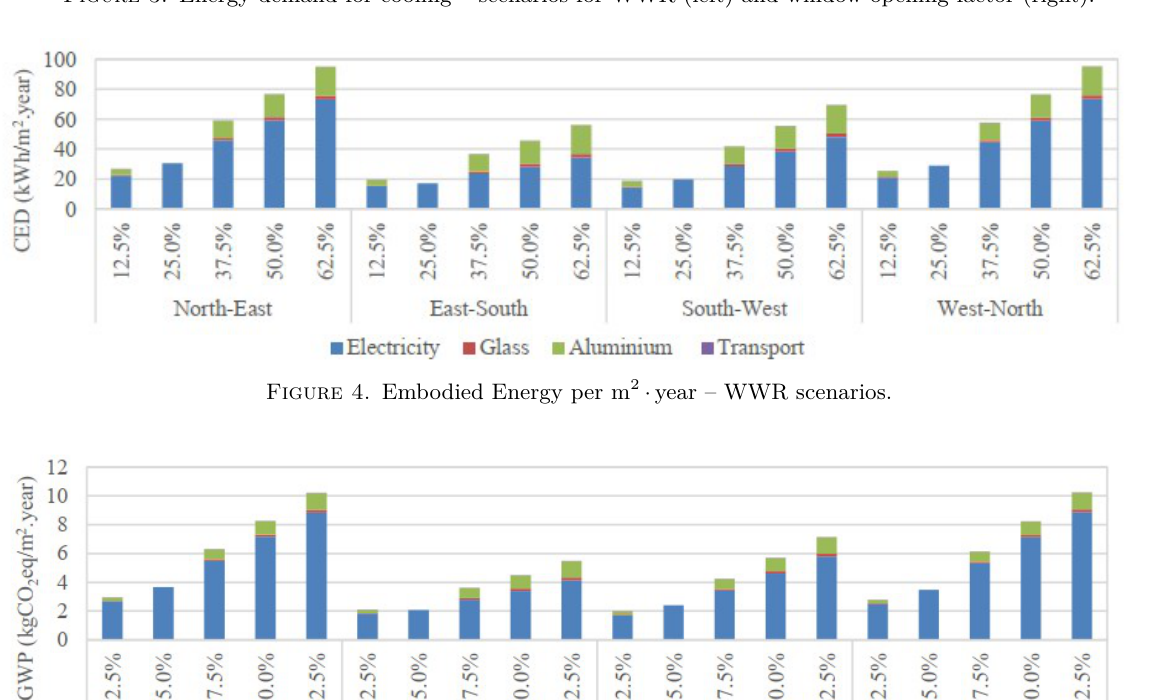
Figure 3. Energy demand for cooling – scenarios for WWR (left) and window opening factor (right).